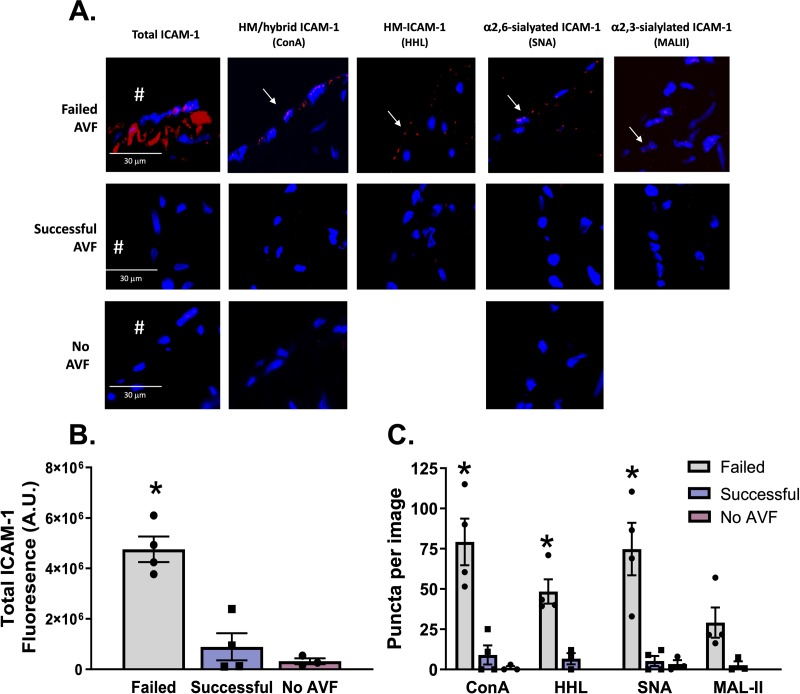
HM / hybrid, HM, α-2,6-sialylated, ICAM-1 are increased CKD patients with failed arteriovenous fistulas.Panel A shows total ICAM-1 (red staining) and specified N-glycoforms in vessels from CKD patients with failed or successful AVF creation. Red puncta represent positive PLA staining (as indicated by arrows). B) Quantification of total ICAM-1 signal in failed and successful AVF samples (n = 4 each). Error bars are mean ± SEM; * p<0.05 compared to successful AVF samples by t-test. C) Quantification of HM / hybrid, HM, α-2,6-sialylated, and α-2,3-sialylated ICAM-1 as puncta per total ICAM-1 signal. Error bars are mean ± SEM; * p<0.05 compared to successful AVF samples by unpaired t-test.